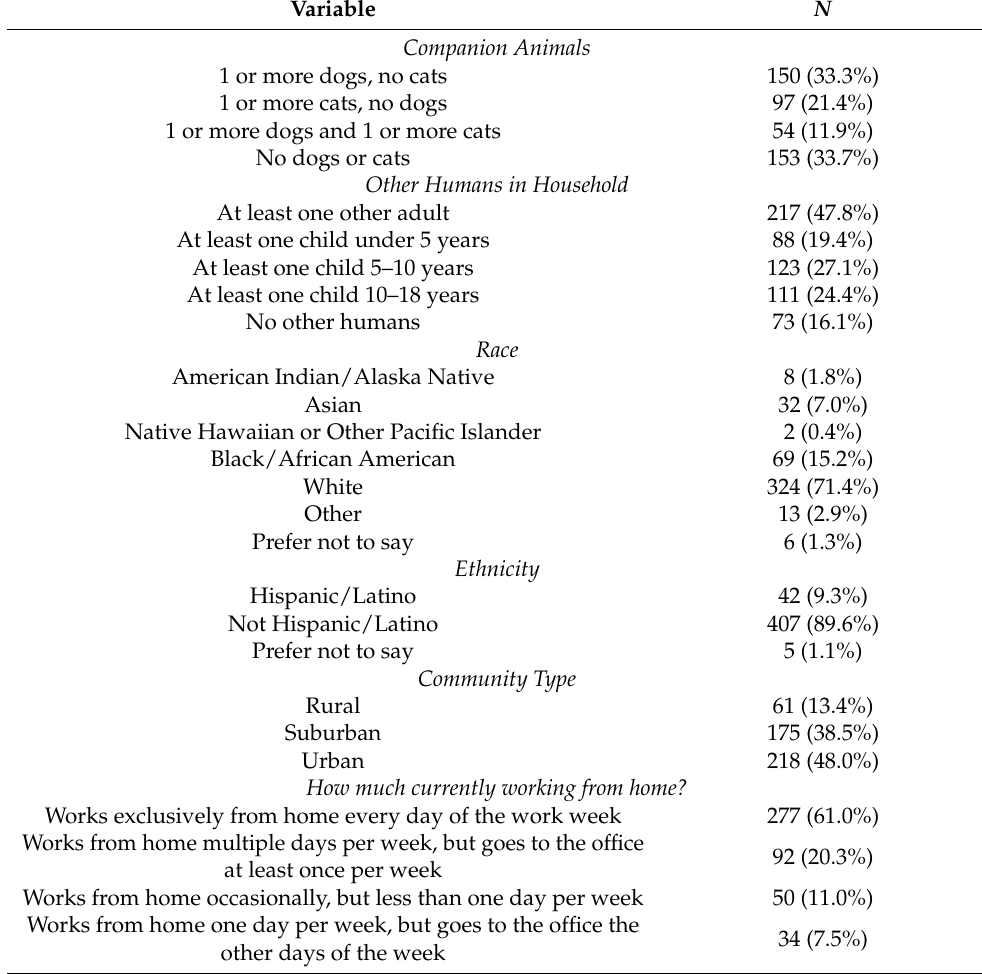
Table 1. Characteristics of the